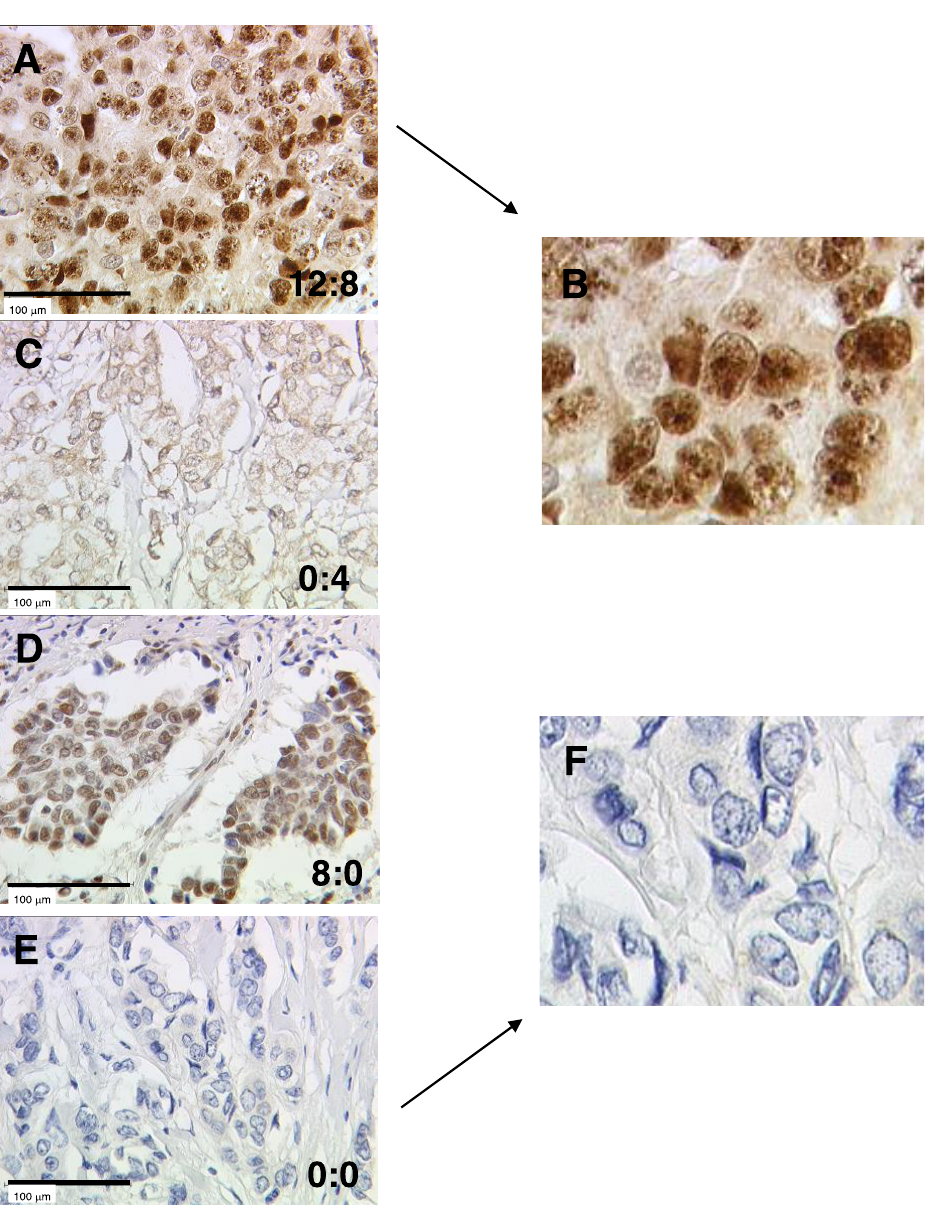
Figure 1. Immunohistochemical staining of thyroid hormone receptor β 1 (THR β 1) in breast cancer samples. THR β 1 staining is illustrated for four patients ( A , C – E ) with examples of absent or high expression. Samples ( A , E ) are enlarged in panels ( B , F ), respectively. Nucleo–cytoplasmic IRS (immunoreactive score) ratios are indicated in each photomicrograph (25× magnification) and the scale bar equals 100 μm.